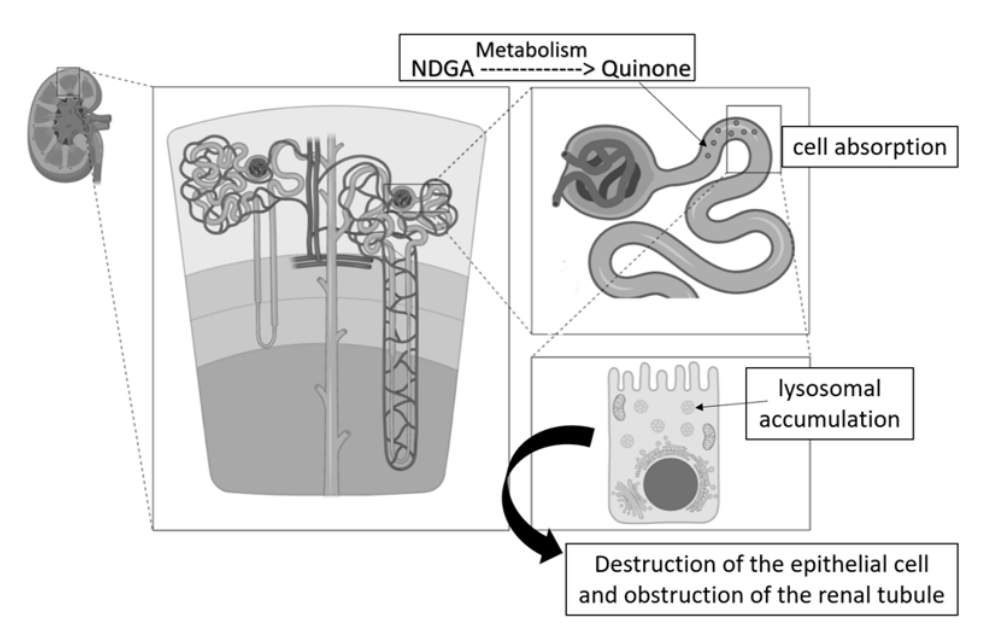
FIGURE 3 - Renal cell death caused by